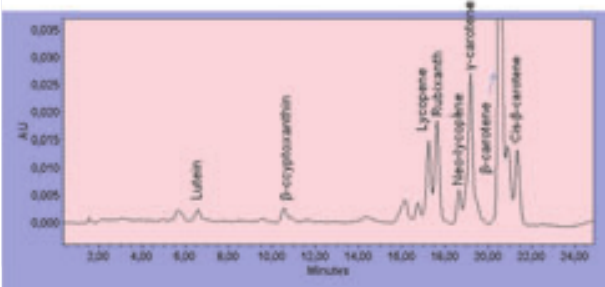
Figure 1. HPLC profile of apricot fruit carotenoids separated on cross-liked ISIS column with gradient elution of water in acetone and detected at 450 nm. For details see